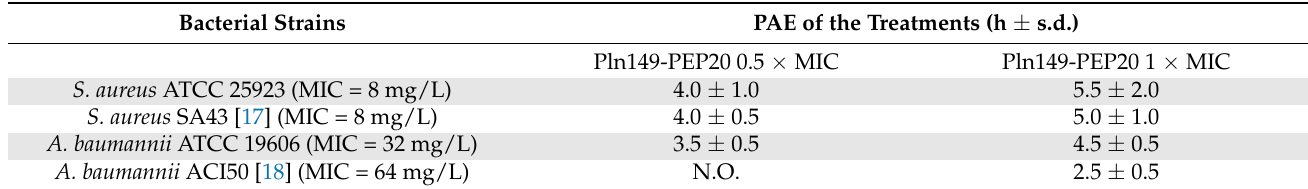
Table 2. Post-antibiotic effect of Pln149-PEP20.